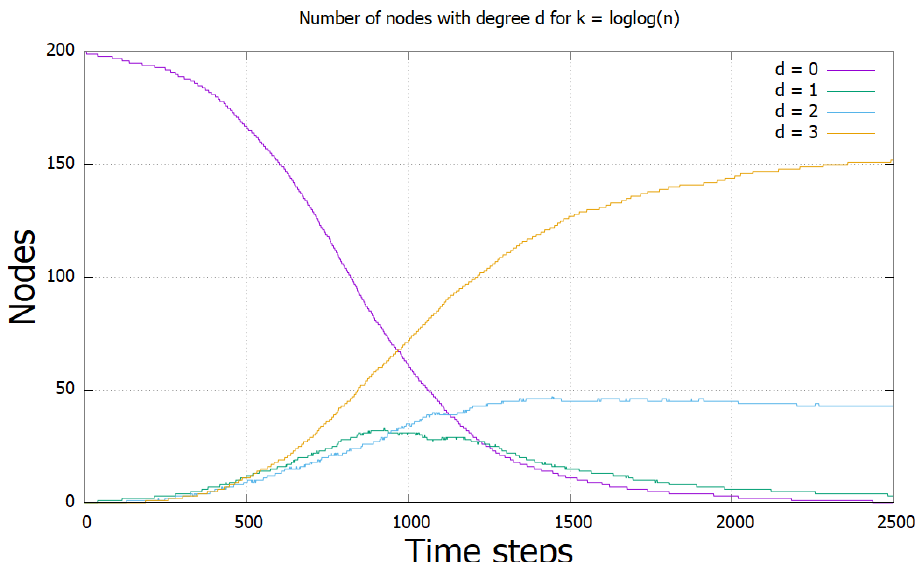
Figure 3. The results for k = loglog n . Note the difference in the axes labels.